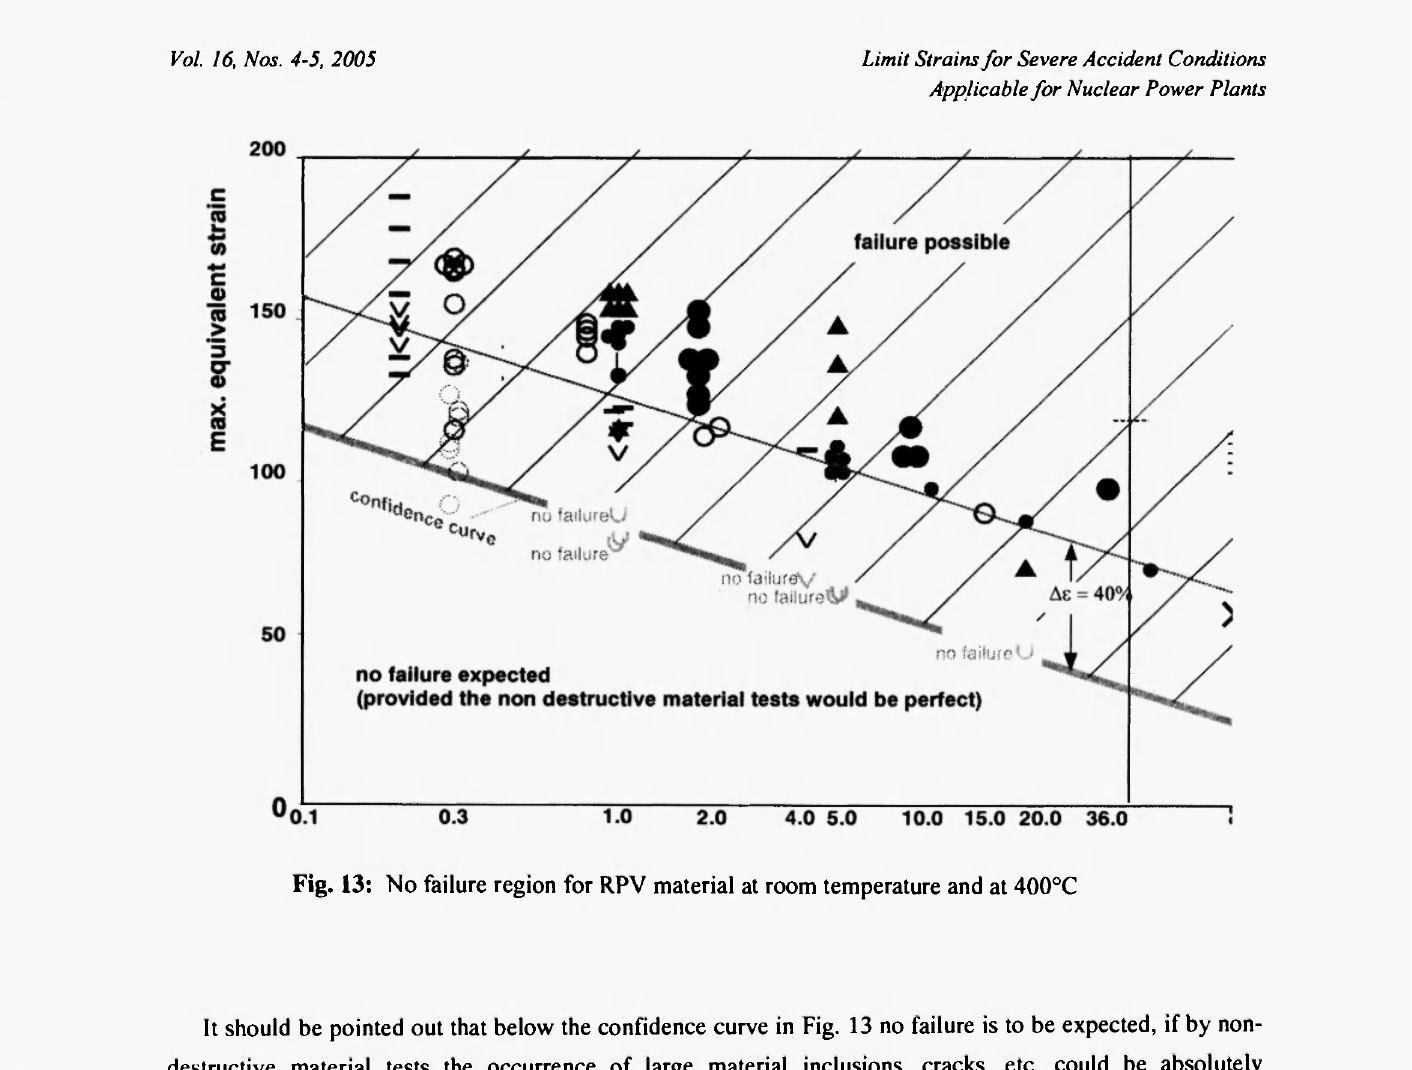
Fig. 13: No failure region for RPV material at room temperature and at